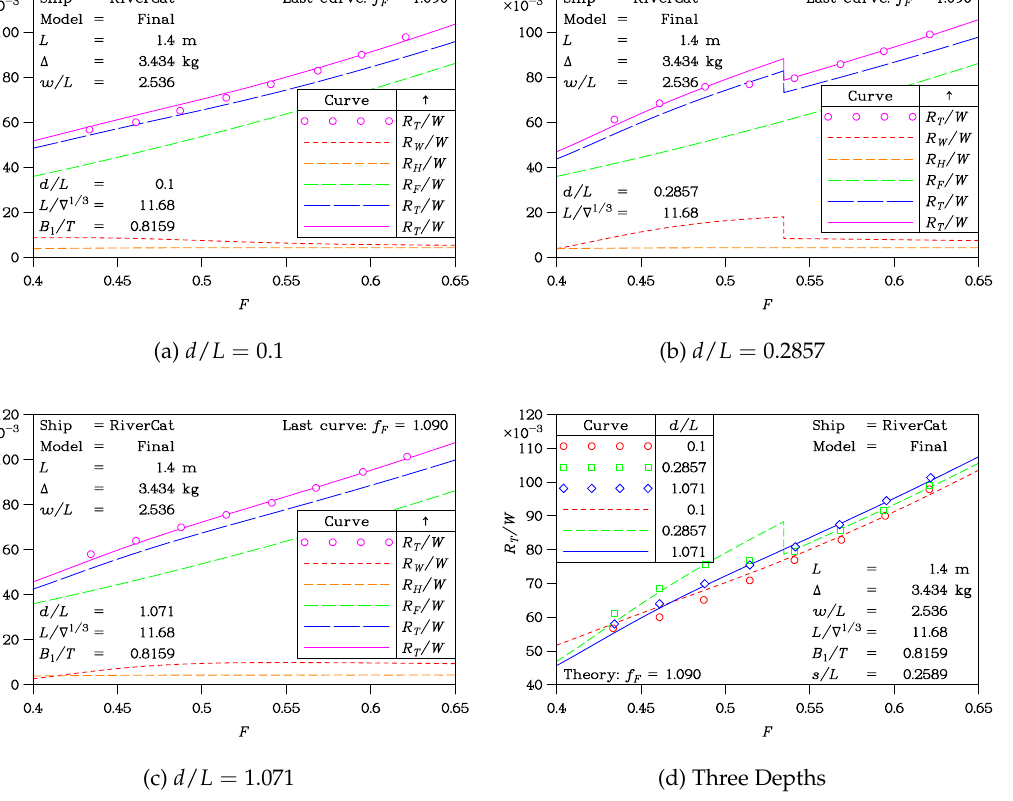
Figure 7. Experiments on Model of Finalized RiverCat